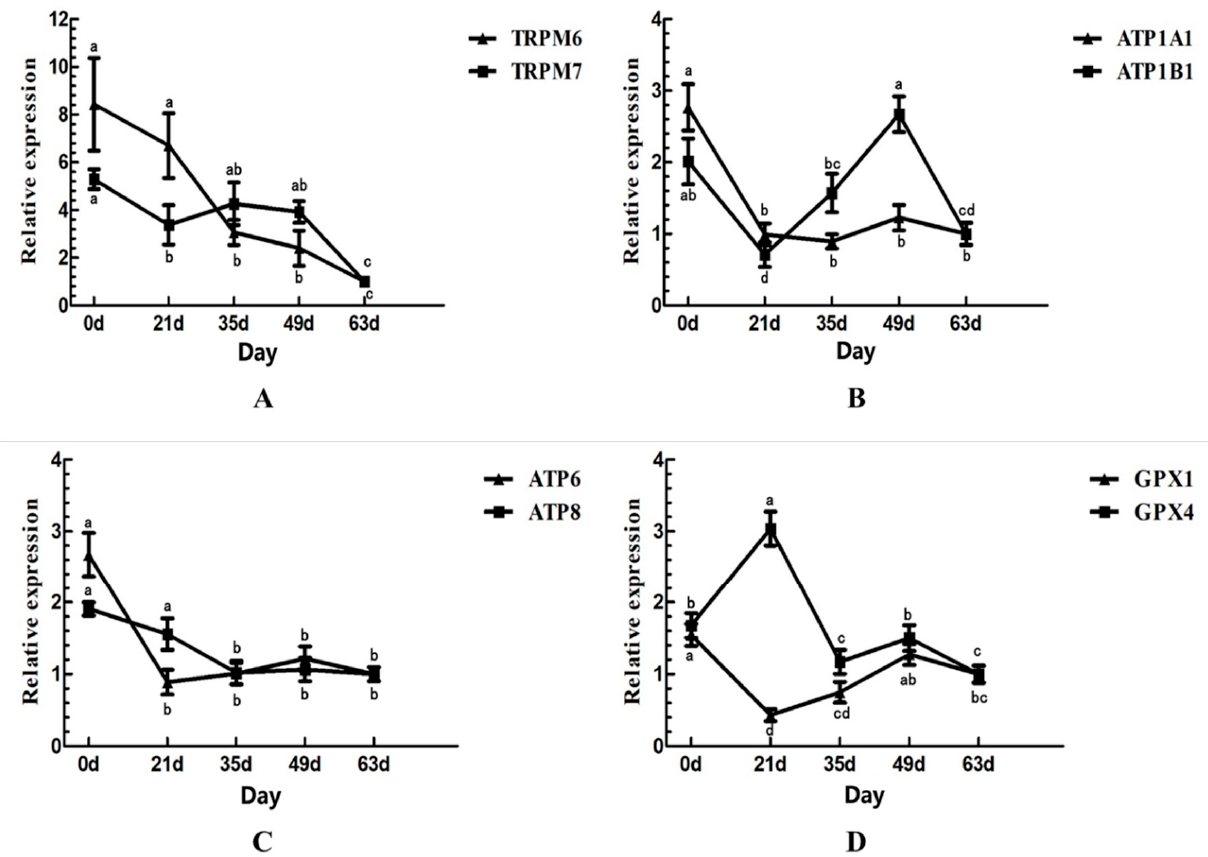
Figure 2. Relative expression of genes in liver. ( A ): Mg-related genes, TRPM6 and TRPM7 ; ( B ): K-related genes, ATP1A1 and ATP1B1 ; ( C ): Zn-related genes, ATP6 and ATP8 ; ( D ): Se-related genes, GPX1 and GPX4 .